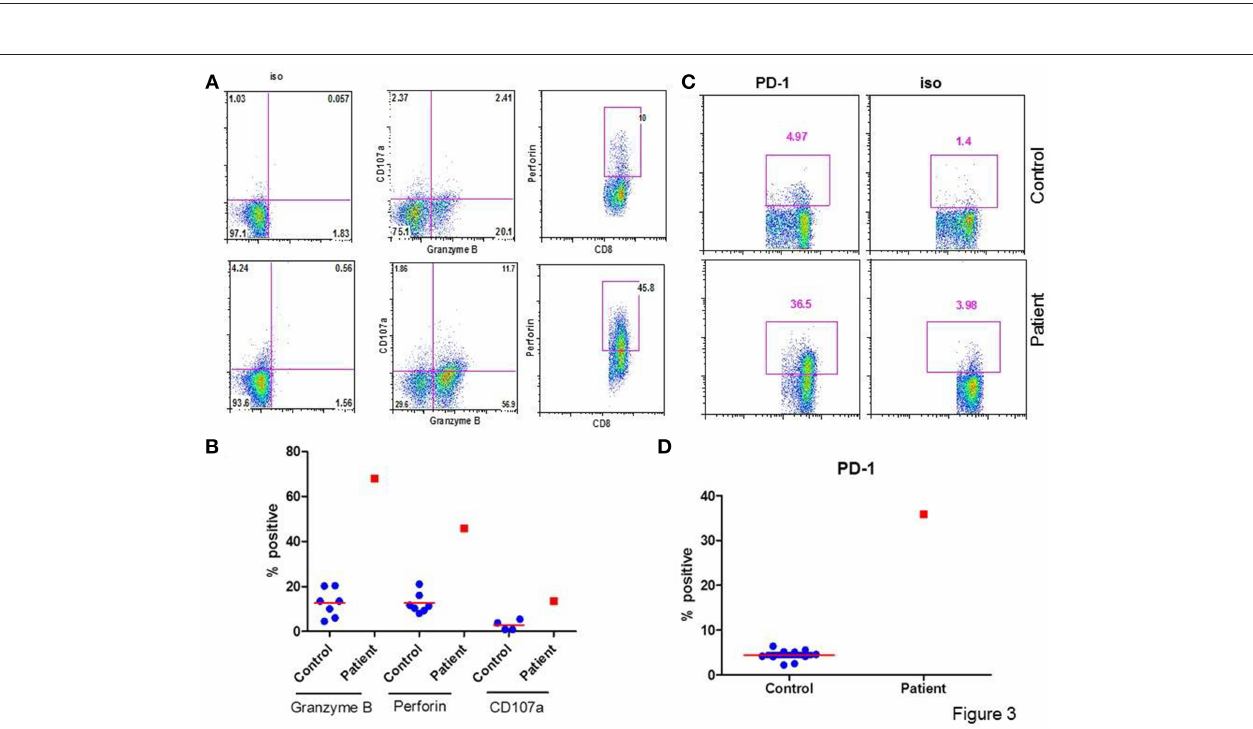
FIGURE 3 | Granzyme B + , Perforin + , and PD-1 + CD8 + T cells. (A) shows a flow cytograph for 107a + , granzyme B + , and perforin + CD8 + T cells. (B) shows individual data from 5 healthy control subjects and the patient. (C) shows a flow cytograph of PD-1 + CD8 + T cells in the patient and a simultaneously-analyzed healthy control. (D) show individual data of PD-1 + CD8 + T cells in 10 healthy controls and the patient. Granzyme B + , CD107a + , Perforin + , and PD-1 + CD8 + T cells are increased in the patient.